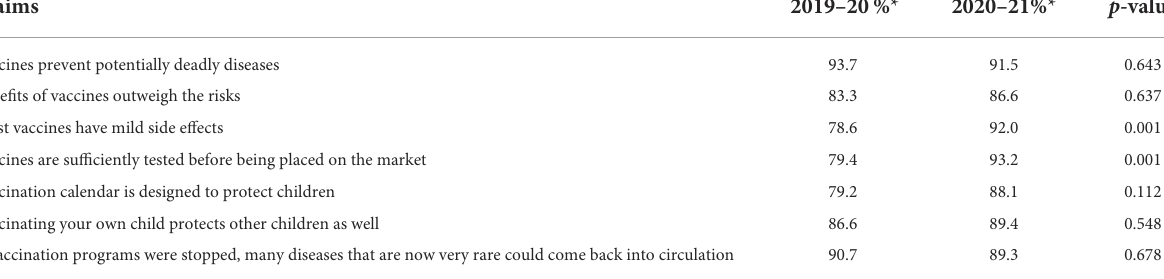
TABLE 2 Knowledge and beliefs about vaccines before and during the COVID-19 pandemic in the flu seasons 2019–20 and 2020–21.